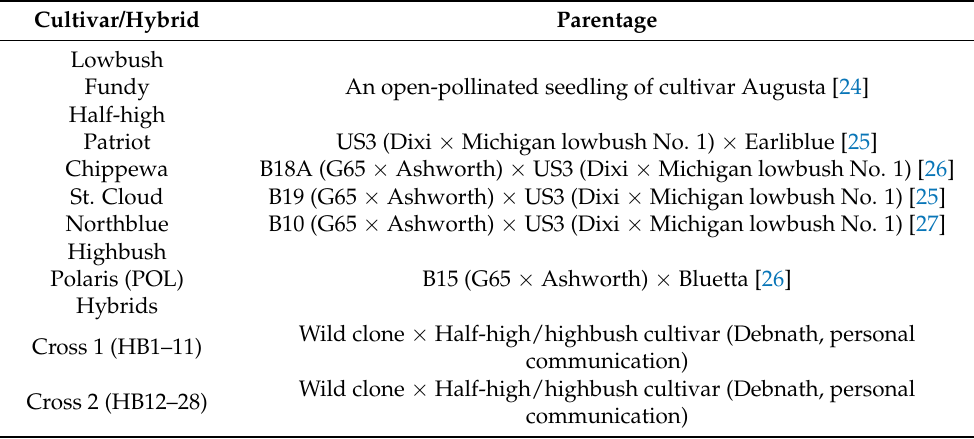
Table 1. Parentage of lowbush, half-high, and highbush blueberry cultivars and hybrids.